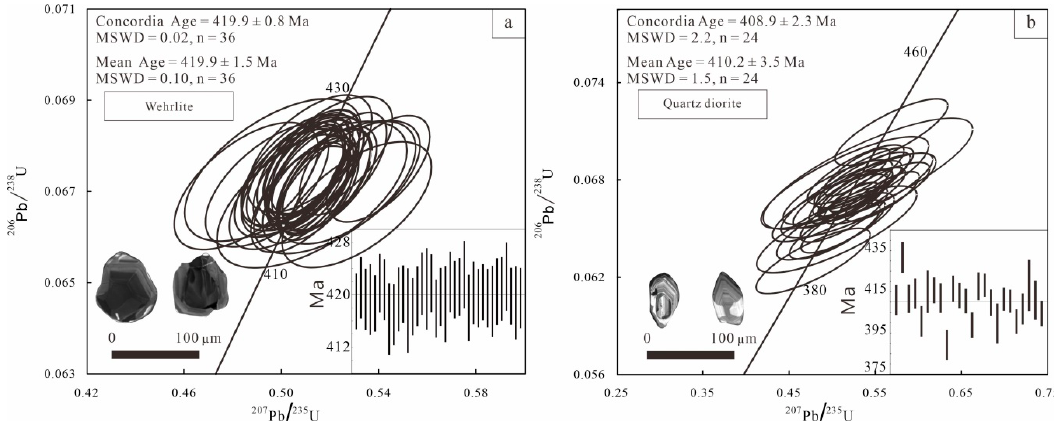
Figure 4. Concordia diagrams for zircon laser ablation inductively coupled plasma mass spectrometry (LA-ICP-MS) U-Pb dating for the Gayahedonggou Wehrlite ( a ) and Quartz diorite ( b ).